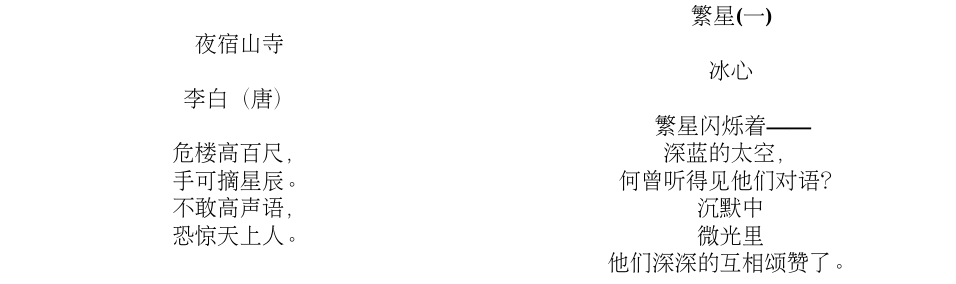
Table 1. Comparison between Jinti poetry (left) and new poetry in vernacular Chinese (right). 夜 宿 山 寺 李 白 （ 唐 ） 危 楼 高 百 尺 ， 手 可 摘 星 辰 。 不 敢 高 声 语 ， 恐惊 天 上人 。